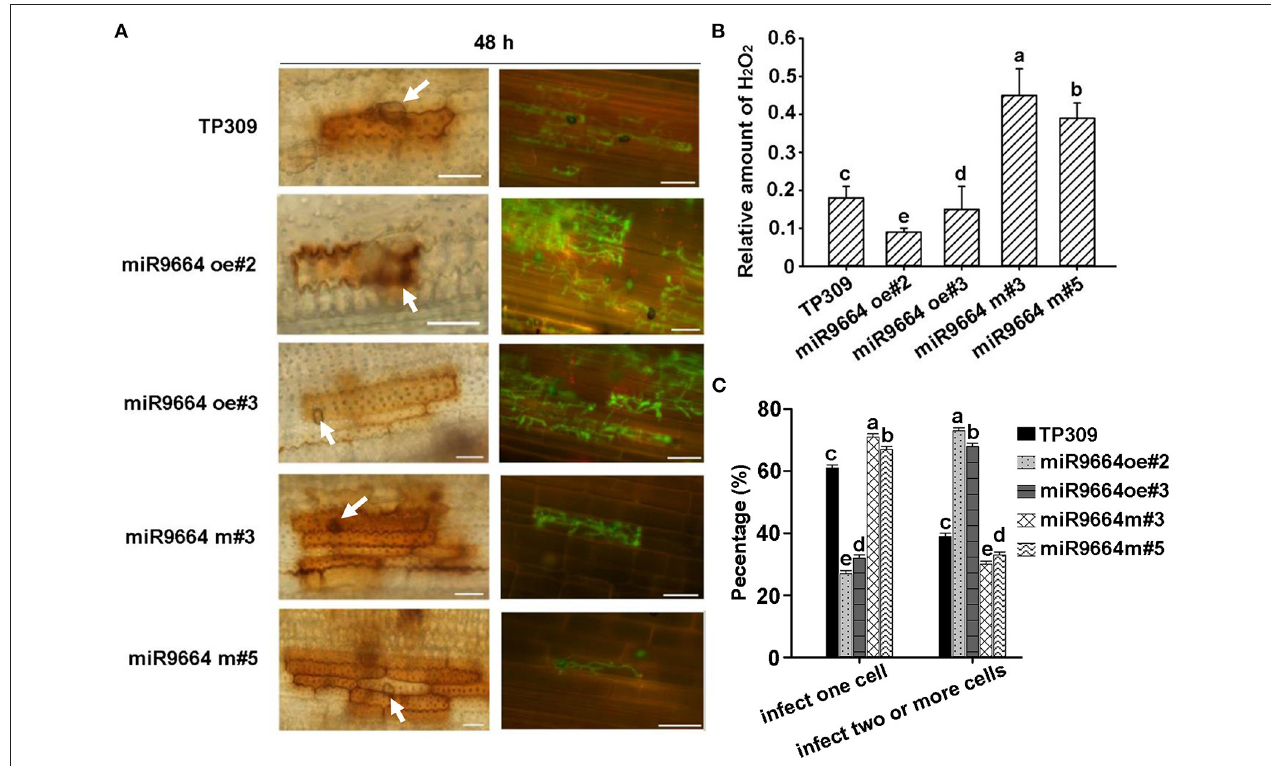
FIGURE 7 | Cellular responses to M. oryzae infection. (A) Diaminobenzidine (DAB) staining at the infection sites of TP309, miR9664-oe, and miR9664-m plants at 2 dpi (left). The tawny shading indicates the accumulation of hydrogen peroxide (H 2 O 2 ), the arrows indicate the infection structure of appressoria; Representative laser scanning microscopy images of TP309, miR9664-oe, and miR9664-m sheath cells infected by the eGFP-tagged blast isolate Zhong 10-8-142 dpi (right). Scale bars, 20 µ m. (B) Quantitation of H 2 O 2 shown in (A) left. The relative amount of H 2 O 2 was calculated based on the pixels taken with Photoshop, using the formula: H 2 O 2 area per rectangle = pixel of H 2 O 2 area per leaf/pixel of the rectangle. Error bars represent the SD of three replicates ( n = 3), the letters above the bars indicate significant differences ( P < 0.01). (C) Quantitative analysis of M. oryzae growth at 48 hpi. More than 60 conidia in each line were analyzed. Error bars represent SD ( n = 60), the letters above the bars indicate significant differences ( P < 0.01). All of the experiments were repeated three times with similar